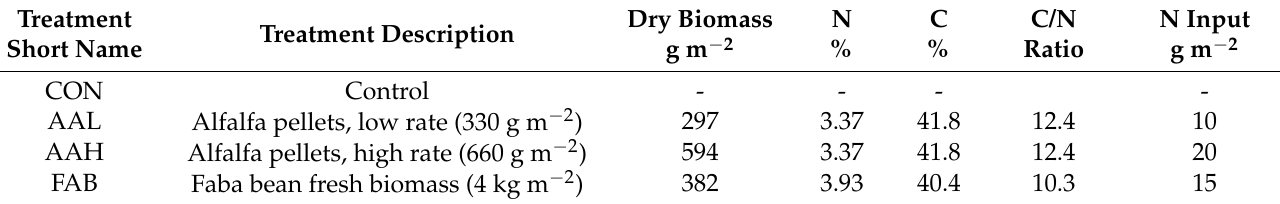
Table 1. Dry biomass, tissue N and C concentrations, C/N ratio and total N input provided via mobile green manure in each treatment. Treatment Short